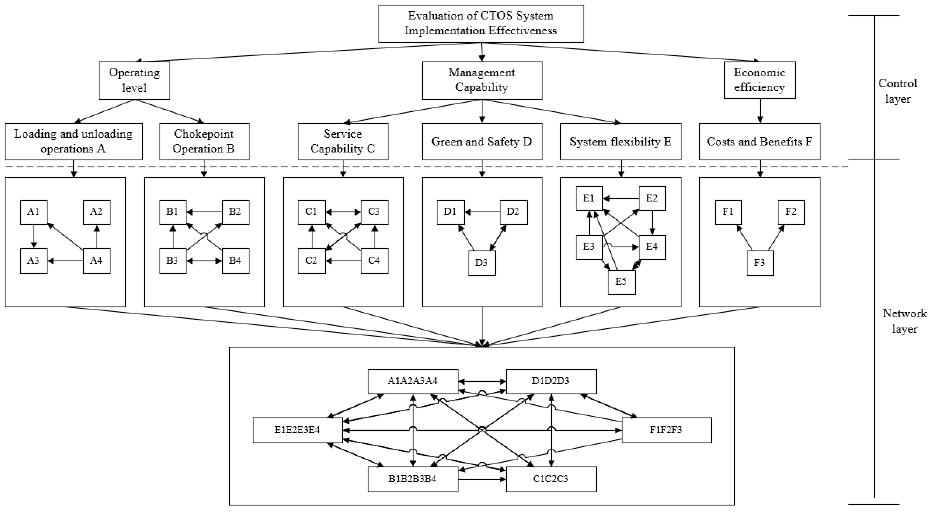
Figure 7. Structural model of the ANP for CTOS construction performance evaluation from a three- dimensional